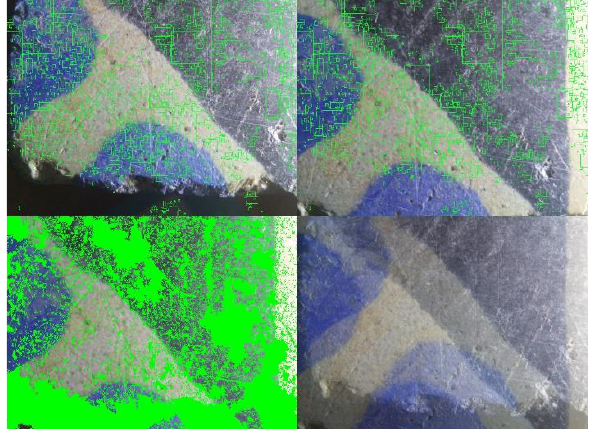
Figure 8 . The RefImage (top left) and Im04 (top right) after computing the SSIM, with green rectangles showing main difference between the two images. The differences can be visualized in the filled image generated by the algorithm (bottom left), and by performing a simple overlay between the two images (bottom